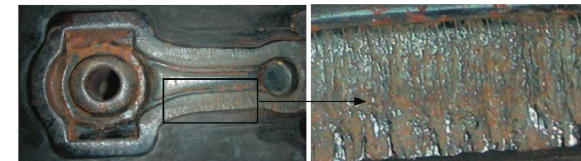
Figure 1: Hot die forging of the connecting rod and detail of the surface of the used H13 forging die showing severe plastic